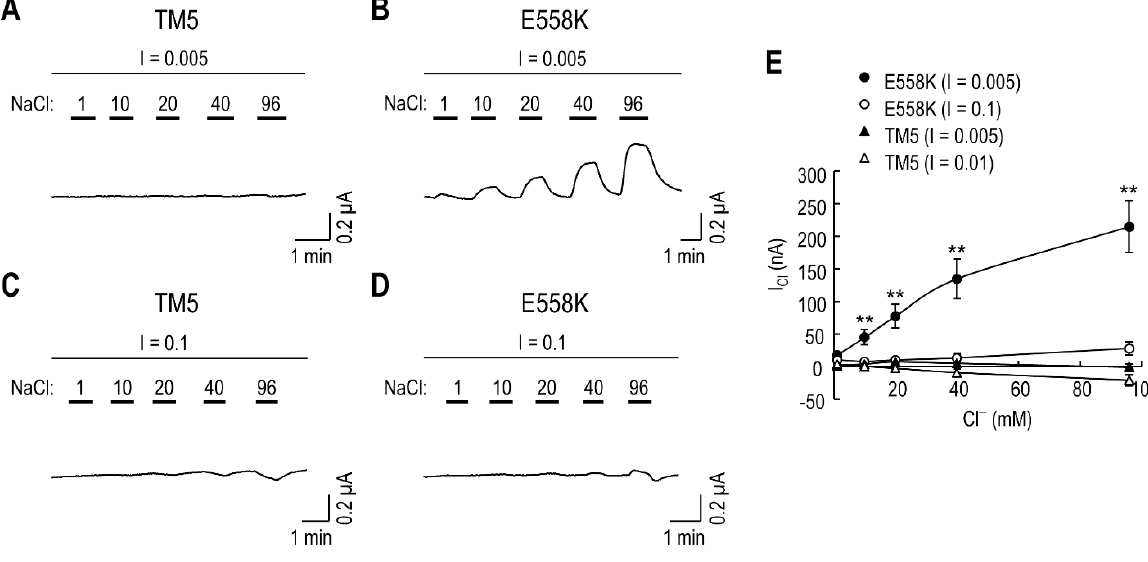
Figure 6. I Cl is affected by solution ionic strengths. ( A , B ) Representative I Cl evoked in solutions with the ionic strength (I) of 0.005 mol/L. An oocyte expressing the TM5 chimera ( A ) or E558K ( B ) was superfused with the low I solution in voltage clamp and exposed to a series of test solutions containing 1–96 mM of NaCl. Each test solution was bracketed with the low I solution to maintain steady-state baseline between test solutions. ( C , D ) Representative I Cl evoked in solutions with I = 0.1 mol/L. Test solutions were applied to an oocyte expressing the TM5 chimera ( C ) or E558K ( D ) while the I was maintained using Na/gluconate. Each test solution was bracketed with Na/gluconate. ( E ) Comparison of I Cl produced by the mutants. I Cl was plotted as a function of Cl − concentration (n = 4–6/group); ** p < 0.01 compared to TM5 (I = 0.005).